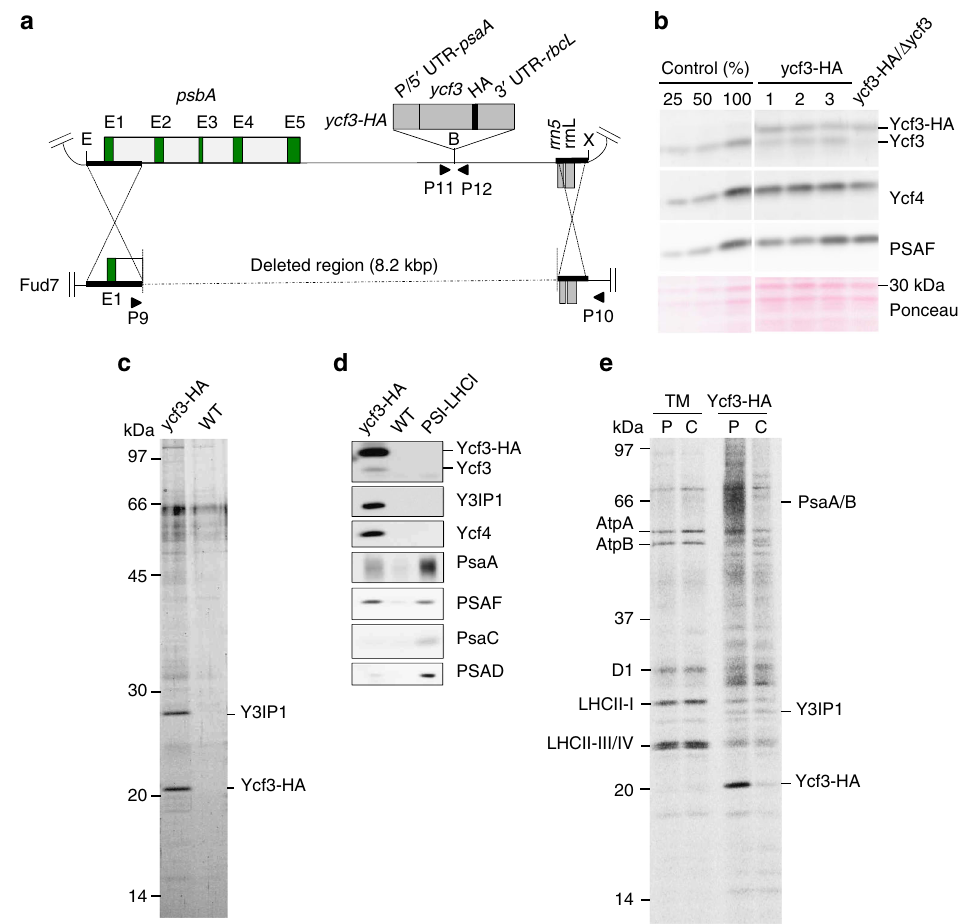
Fig. 1 Ycf3 – Y3IP1 transiently associates with newly synthesized PSI reaction center subunits. a Physical map of the vector containing ycf3-HA expression cassette inserted at the Bam HI site downstream of the psbA gene, which consists of fi ve exons (E1 – E5), is shown. The host strain, Fud7, has an 8.2 kbp deletion starting from the downstream of the E1. The ycf3 cassette contains the coding sequence of ycf3 and HA tag fl anked by P/5 ′ -UTR of psaA and 3 ′ - UTR of rbcL . Ycf3-HA contains HA tag inserted at C-terminus of Ycf3. E, X, and B depict restriction sites for Eco RI, Xho I, and Bam HI, respectively. P9/P10 and P11/P12 represent pairs of primers used for PCR (Supplementary Fig. 1a). b The expression of Ycf3-HA was con fi rmed by immunoblotting. Total